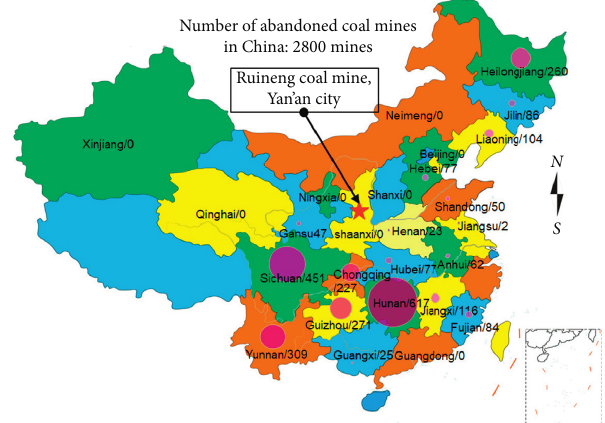
Figure 1: Distribution map of abandoned coal mines in China. Data from Energy Statistics Department of National Bureau of Statistics, China.